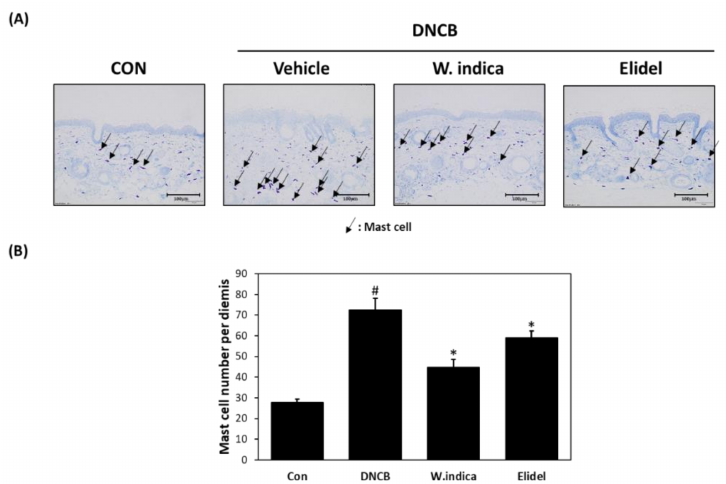
Figure 3. E ff ects of W. indica extract on toluidine blue staining findings and mast cell numbers in dermal tissues. ( A ) Toluidine blue staining result. ( B ) Mast cell numbers. Results are expressed as the means ± SEMs of two independent experiments. # p < 0.05 vs. the CON group; * p < 0.05 vs. the DNCB group. CON: vehicle control group; DNCB: DNCB + vehicle treated group; DNCB + W. indica : DNCB and 1% W. indica extract treated group; and DNCB + Elidel: DNCB and 1% pimecrolimus treated